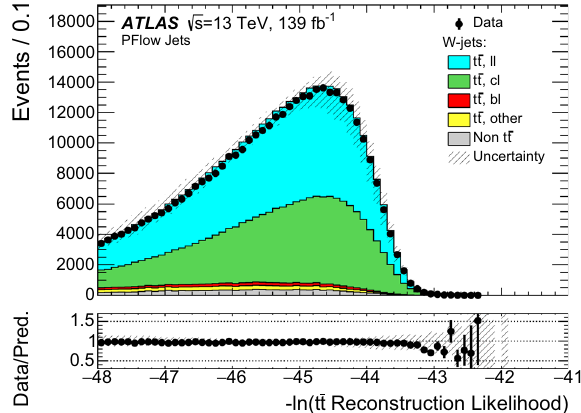
Fig. 1 Distribution of the negative logarithm of the likelihood that is used to reconstruct the t ¯ t decay. Only events with values of this quantity exceeding − 48 are shown, which corresponds to the selection used in the measurement. The t ¯ t simulation is split according to the flavours of the W -jets ( ll , cl , bl and other). The (mis)tagging efficiency scale factors have not been applied to the simulation. The hashed area shows the total uncertainty, excluding the uncertainties from the (mis)tagging efficiency scale factors and the uncertainty on the jet p T distribution, which is derived from the difference between data and simulation